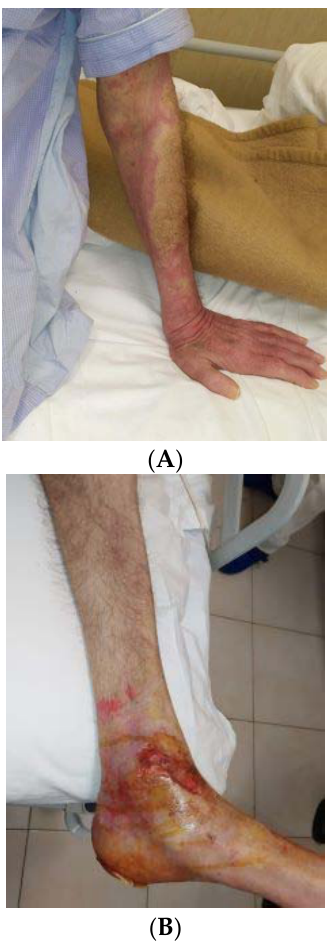
Figure 1. Bullous pemphigoid lesions present in our bipolar patient as urticaria-like red skin without blisters ( A ). Post-blistering erosions localized to the lower left limb ( B ).